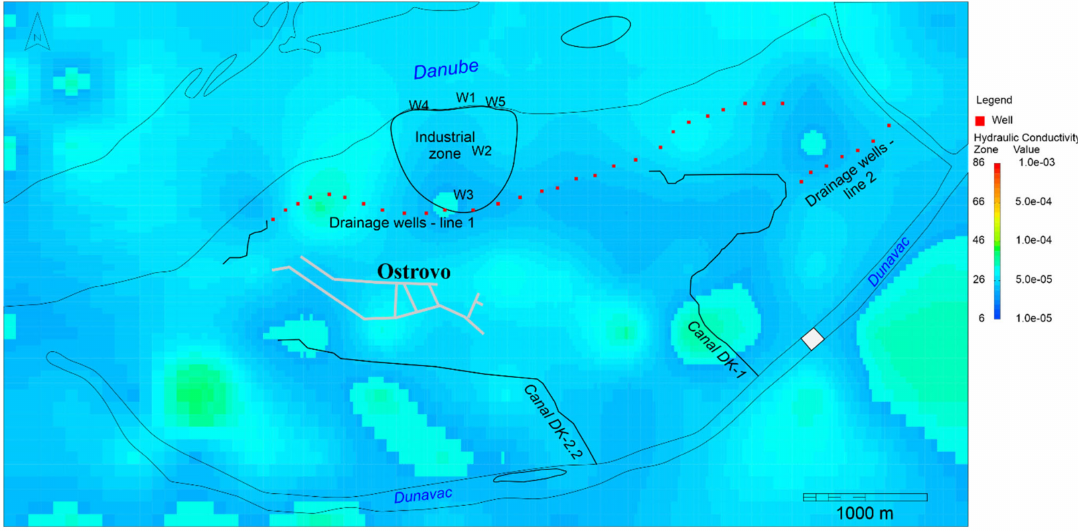
Figure 10. Zones and hydraulic conductivity K x,y matrix of the second model layer.